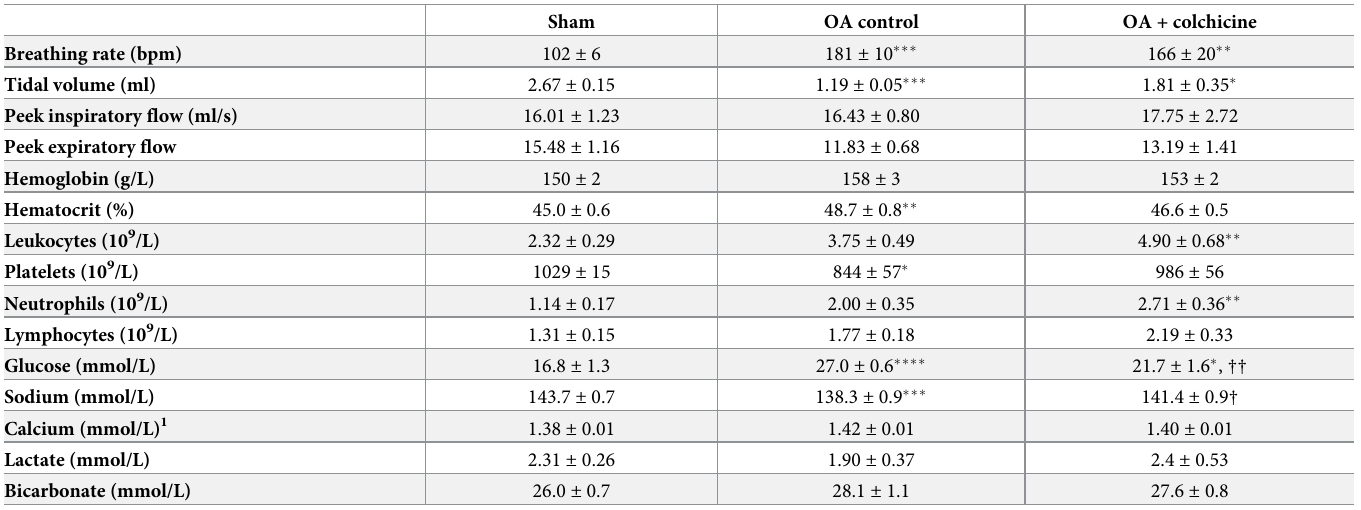
Table 1. Effect of colchicine on respiratory parameters, blood cell counts, and